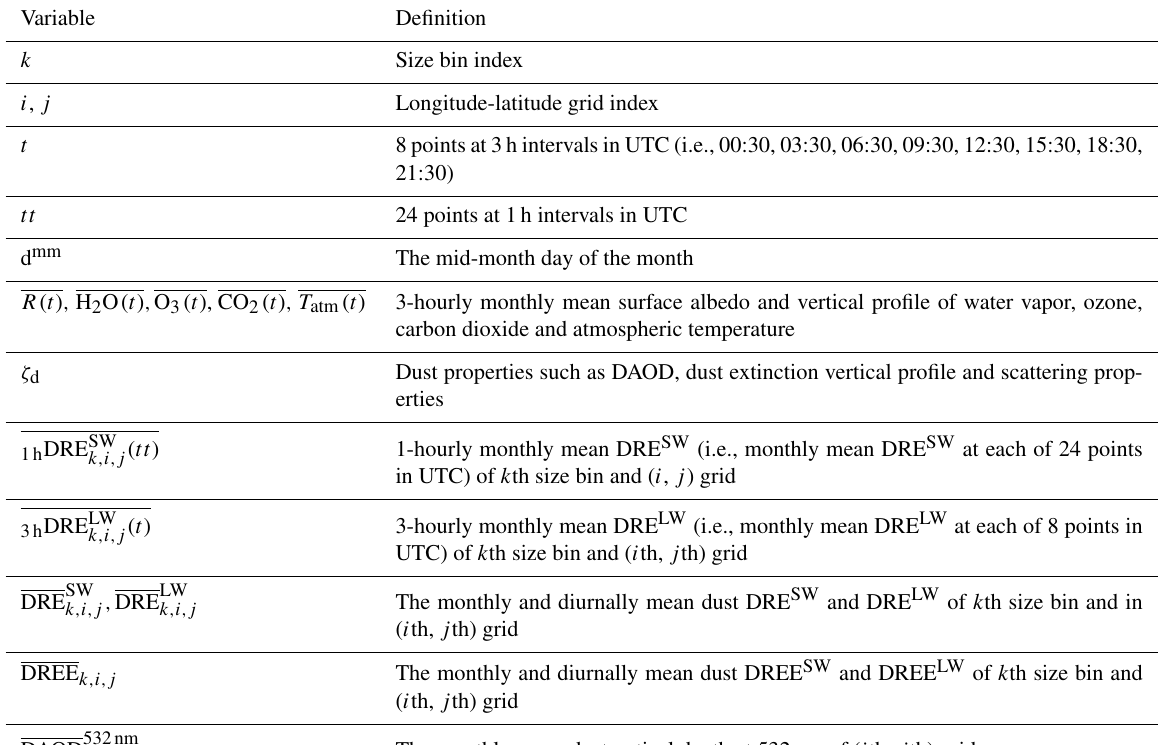
Table 2. List of definitions of variables and their indices.